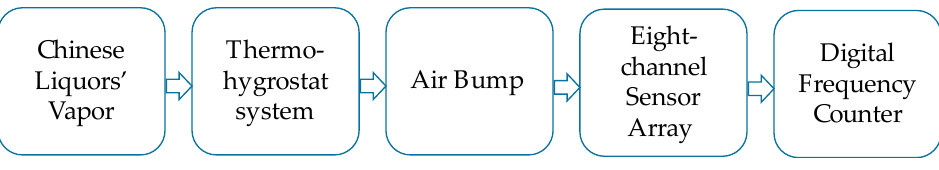
Figure 2. The working flow chart of the e-nose.